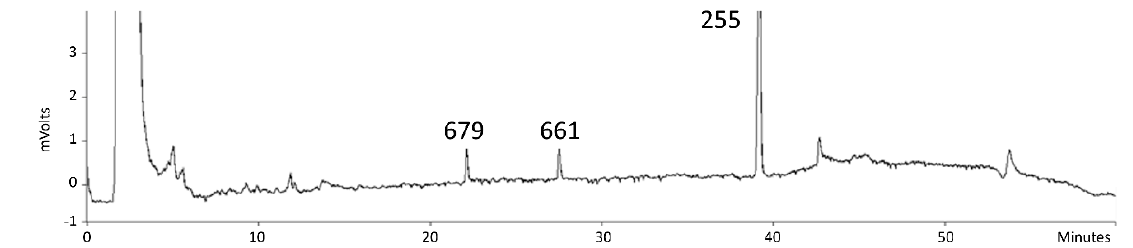
Figure 2. HPLC in conjunction with an evaporative light scattering detector (ELSD) chromatogram of the sophorolipid production of the CYP1BMR strain grown on palmitic acid after eight days in the stationary phase. Products detected are di-acetylated acidic C16:0 sophorolipids (679 m / z , 22.2 min), di-acetylated lactonic C16:0 sophorolipids (661 m / z , 27.5 min), and the substrate palmitic acid (255 m / z , 39.2 min).